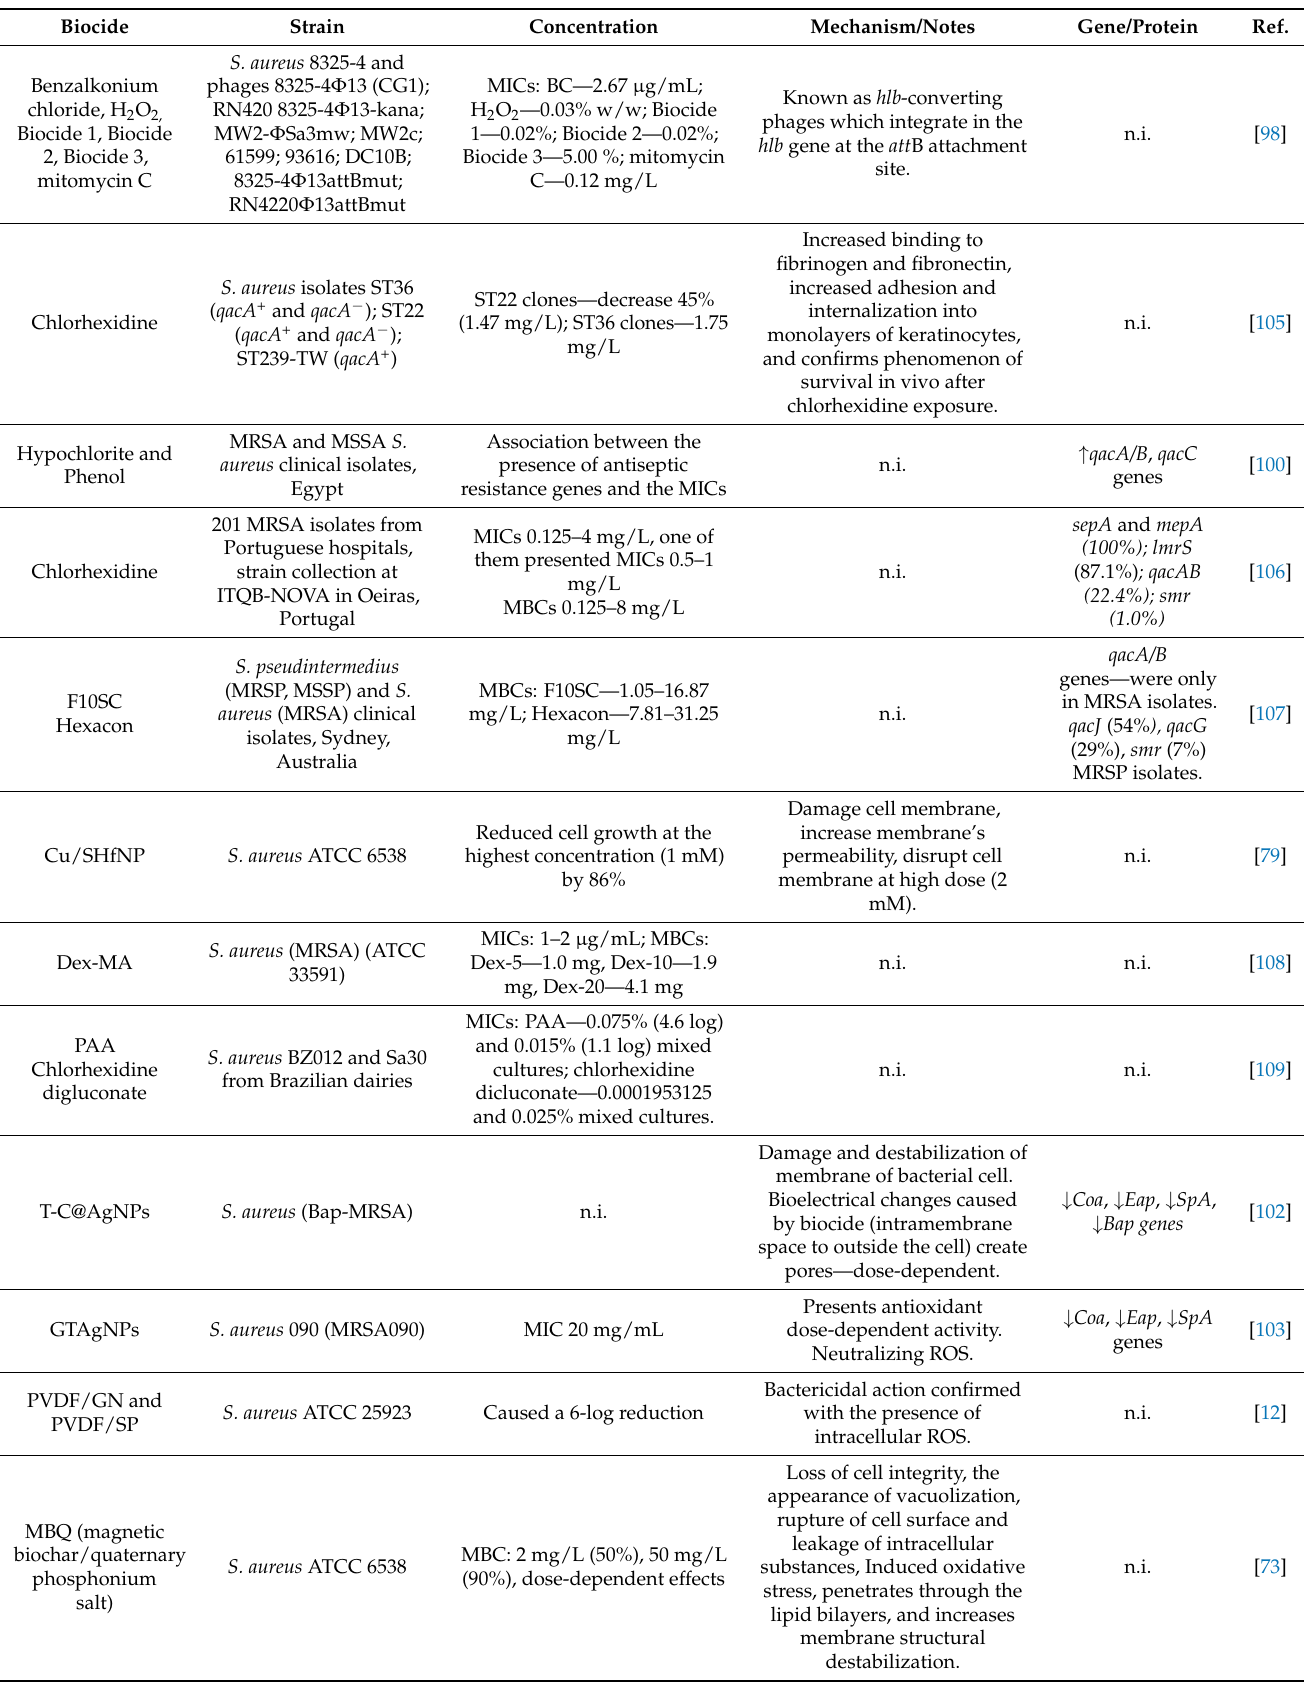
Table 4. Biocides and their impact on Staphylococcus